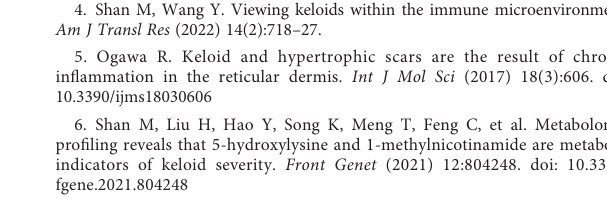
SUPPLEMENTARY FIGURE 1 Differentially expressed genes (DEGs)in cellular subtypes between keloids and normal skin tissues. (A) Heatmap illustrating DEGs in fi broblast subtypes. (B) Heat map exhibiting DEGs in macrophage subtypes. SUPPLEMENTARY FIGURE 2 Spatial cell cluster analysis of keloids scanned by Hyperion imaging mass cytometry. (A) Immunohistochemical fi eld for the selected Hyperion tissue imager scan on 5 mm×5 mm formalin- fi xed, paraf fi n-embedded tissue slide (Gross appearance, 40X and 100X). (B) Cell cluster analysis the specimen. t-SNE descending dimension map of different cell types. (C) Representative images of tissue mass spectrometry stained with CD3, CD4, CD11c, CD45RA, CD68 and other antibodies. The picture on the right is a 5 times magni fi cation of the yellow box on the left. SUPPLEMENTARY FIGURE 3 Comparison of cell counts between keloids and normal skin tissues in T- cell subpopulations. SUPPLEMENTARY FIGURE 4 Comparative expression of pro- and anti-in fl ammatory cytokines and chemokines between keloids and normal skin tissues in general (A) , fi broblasts (B) , macrophages (C) , dendritic cells (D) and T cells (E)